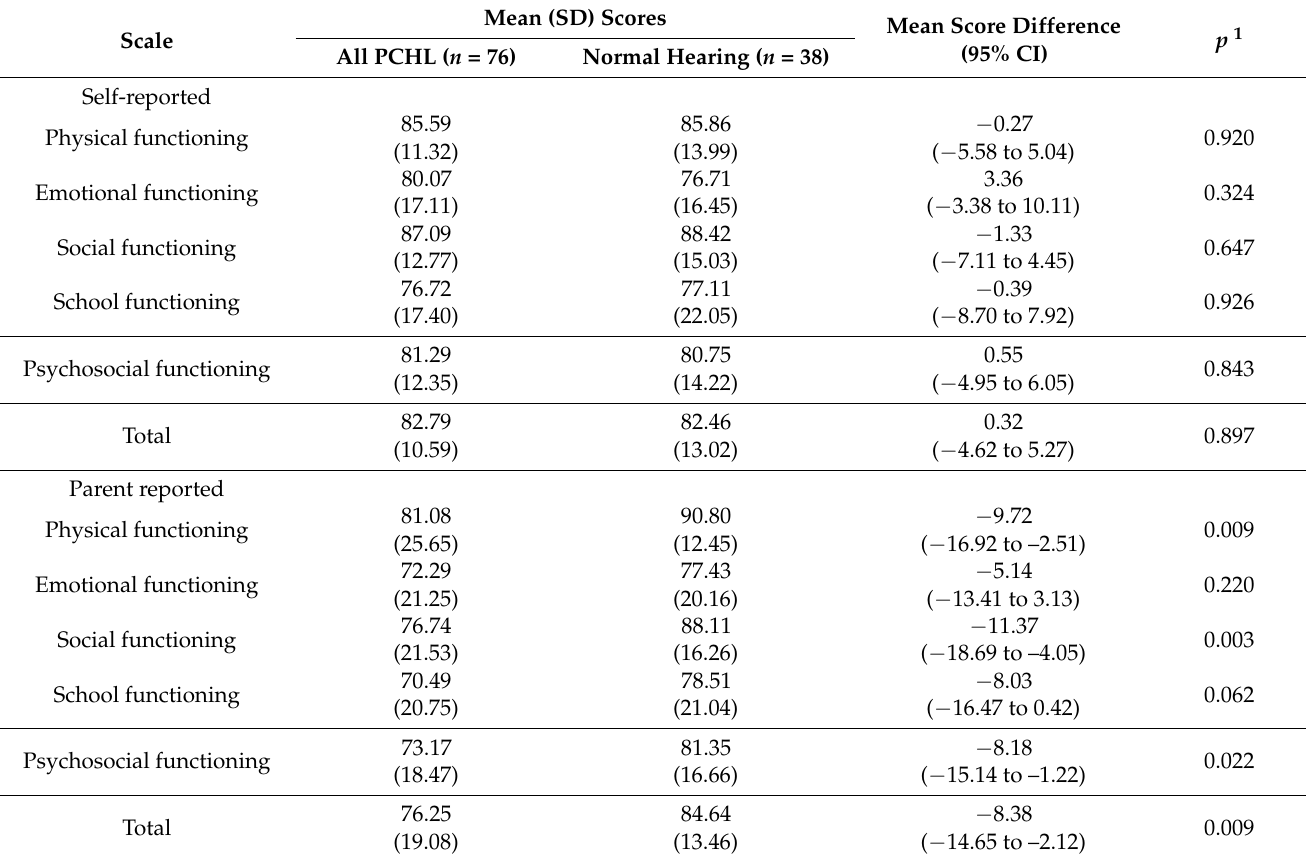
Table 3 presents descriptive statistics for the PedsQL TM scale, psychosocial and total scores. Based on self reports, there were no significant differences in mean scores the PedsQL TM scale, psychosocial and total scores between the adolescents with PCHL and those with normal hearing (Table 3). However, based on reports by the parent proxies, mean scores were significantly lower for physical functioning (81.08 vs. 90.80: p = 0.009), social functioning (76.74 vs. 88.11: p = 0.003), psychosocial functioning (73.17 vs. 81.35: p = 0.022) and for the total score (76.25 vs. 84.64: p = 0.009) amongst adolescents with PCHL (Table 3). Table 3. PedsQL Generic Core Scales health-related quality of life scale scores by severity of hearing loss. Mean (SD) Scores Mean Score Difference Scale Normal Hearing ( n = 38)